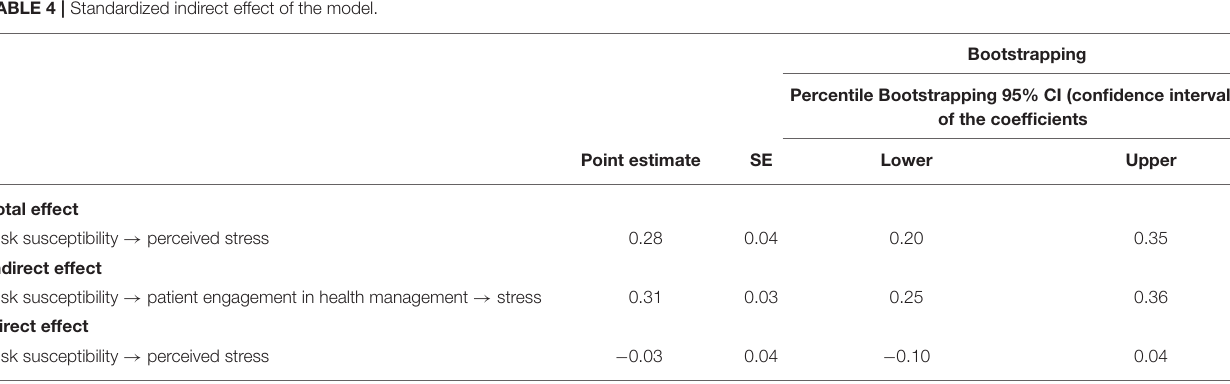
TABLE 4 | Standardized indirect effect of the